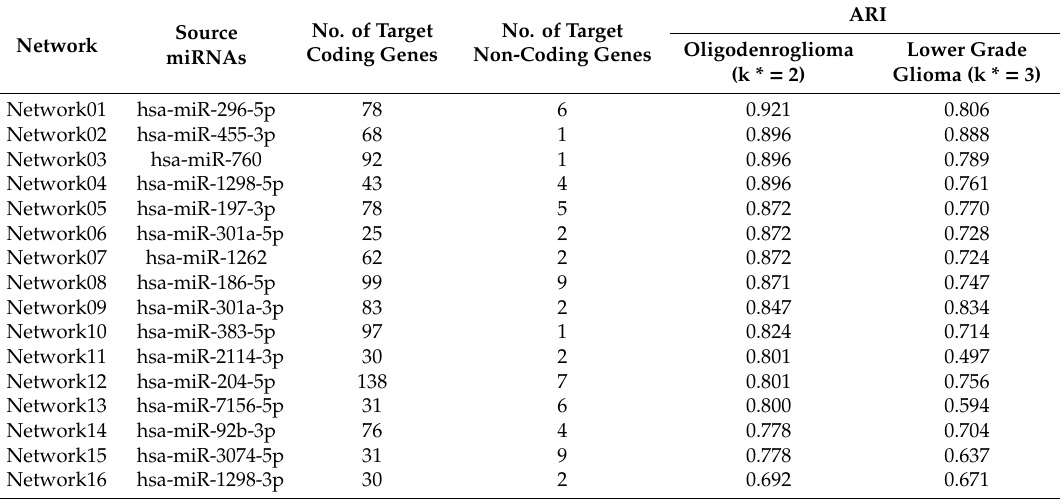
Table 1. Compare with Oligodenroglioma and Lower grade glioma using by adjusted rand index (ARI) evaluation of ceRNA